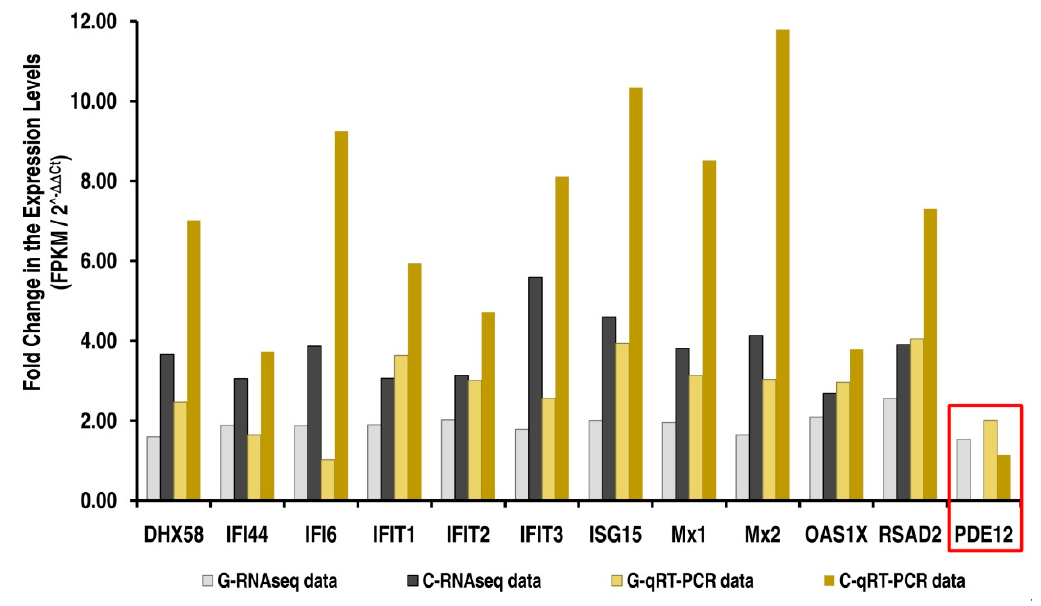
Figure 6. Comparing the expression levels selected differentially expressed target genes (RNA-Seq vs RT-qPCR) in response to PPRV infection in Goat vs. Cattle. The fold change in the FPKM values of the identified target genes from the RNAseq data has been compared with the fold change in the expression levels validated by RT-qPCR experiments. The expression levels of the negative regulator of the 2 ′ ,5 ′ -oligoadenylate system probably contributing to the decreased antiviral state induced by the interferons is boxed in red; G, Goat; C, Cattle.